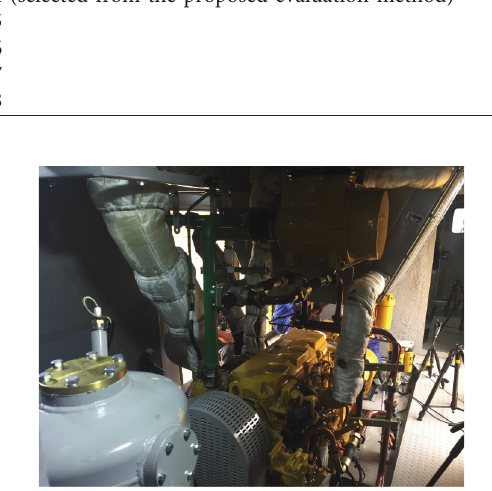
Figure 12: In situ test set-up.